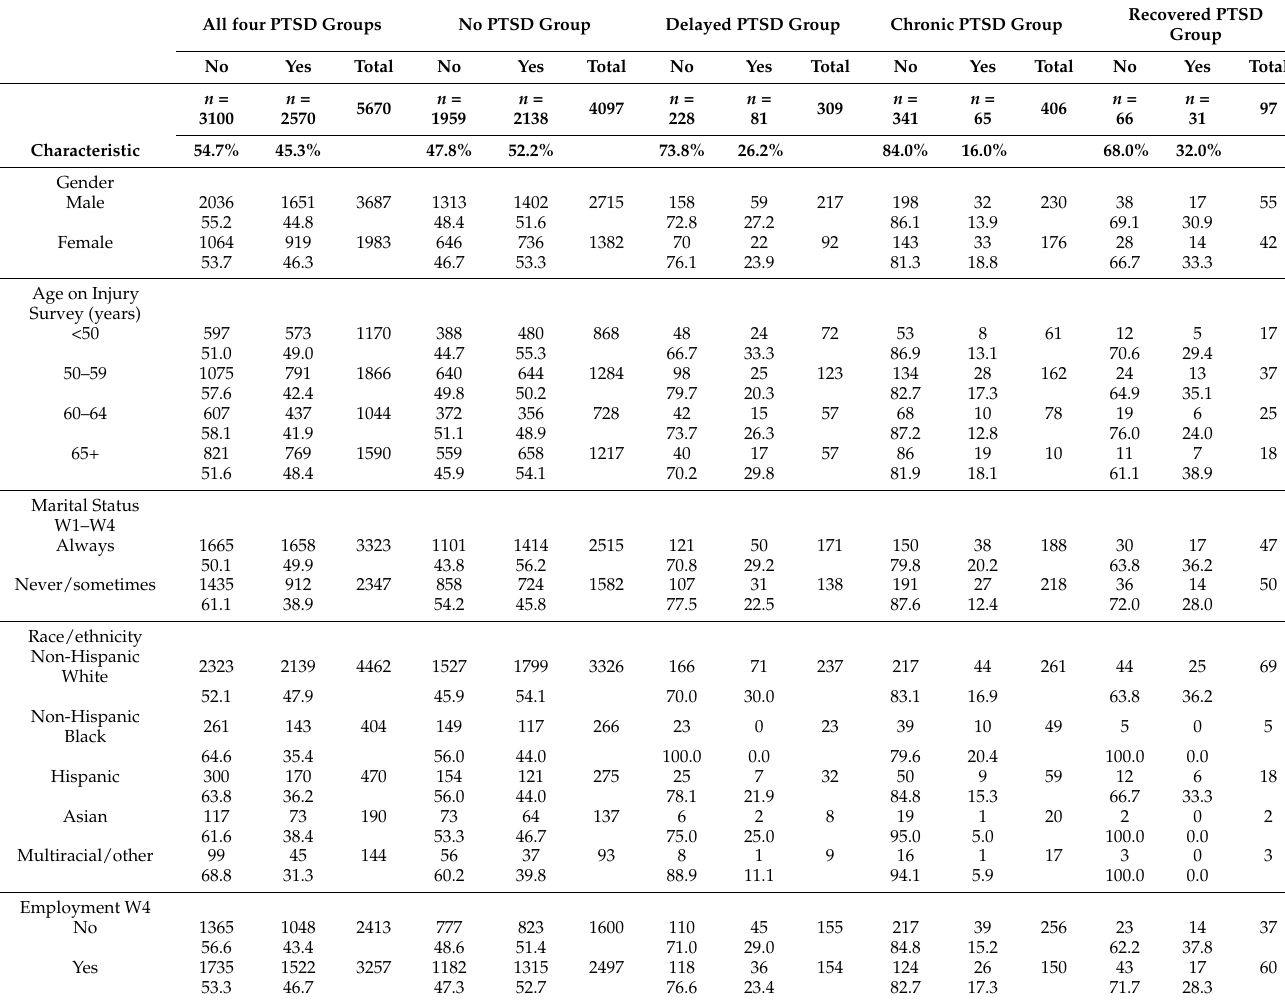
Table 1. Distribution of demographic factors and psycho-social factors with social